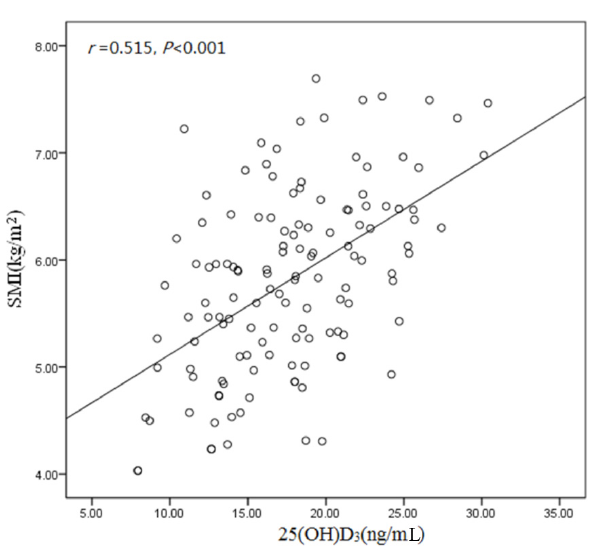
Fig. 1. Correlation between SMI and serum 25(OH)D plot indicates a positive correlation between SMI and serum 25 (OH) D3 levels (r=0.515, P <0.001).